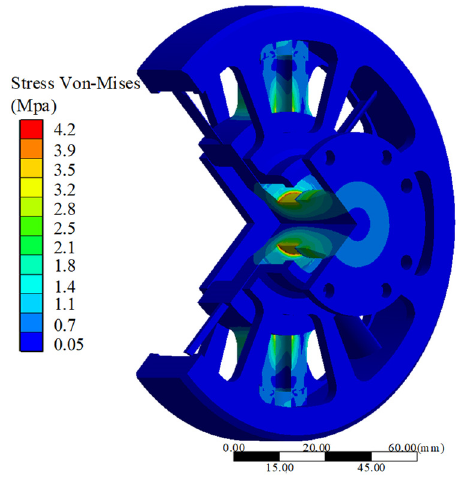
Figure 4. SMA fan clutch stress distribution.